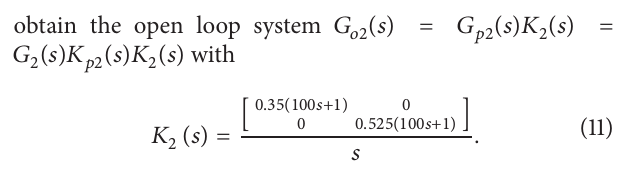
The eigenvalues of [𝐺 𝑜2 (𝑗𝜔)+𝐺 ∗ 𝑜2 (𝑗𝜔)] (Figure 5)